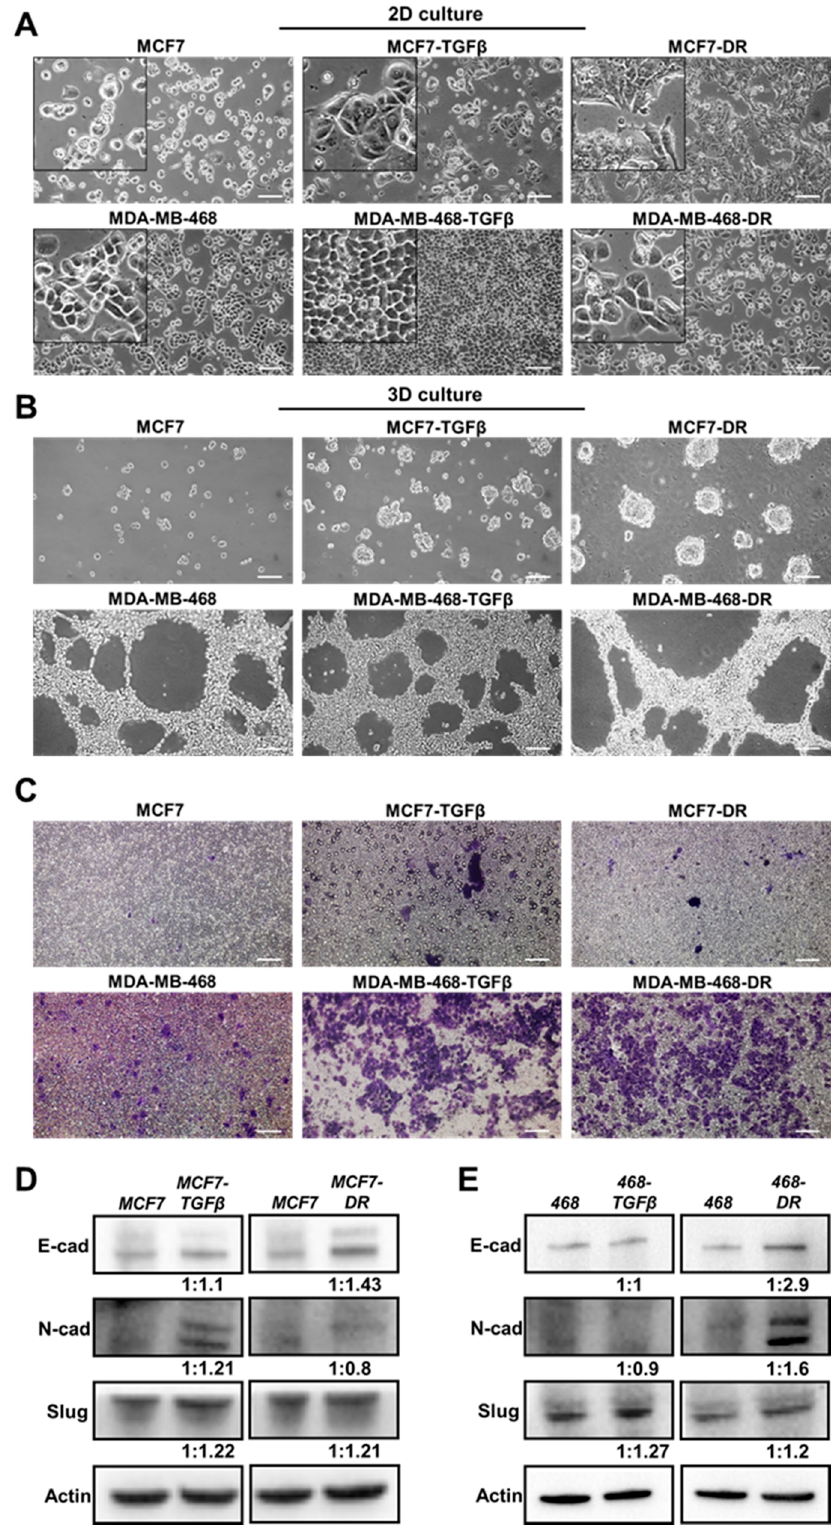
Figure 2. Altered growth and morphology and enhanced invasion in breast cancer cells with TGF- β treatment and drug resistance. MCF7 and MDA-MB-468 cells were cultured in 5 ng/mL TGF- β for 7–15days to obtain MCF7-TGF- β and MDA-MB-468-TGF- β , cells, respectively. MCF7-DR and